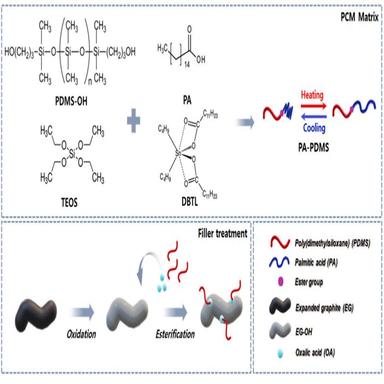
Schematic illustration of the PA-PDMS/EG-PDMS composites.